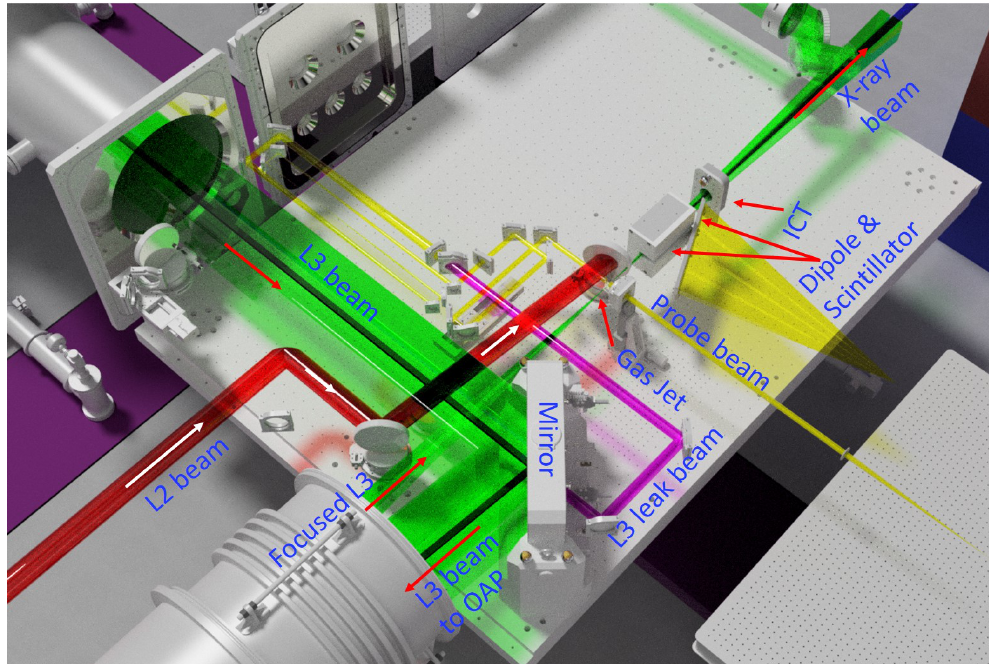
Figure 7. Detailed view of the Gammatron beamline operating in the ICS scheme and the associated diagnostics inside the interaction chamber. An L3 beam drives the LPA, and an auxiliary laser beam (split off of L3 or L2 (red)) will be used as a scattering beam which is focused on the downstream portion of the gas jet using a short-focal-length